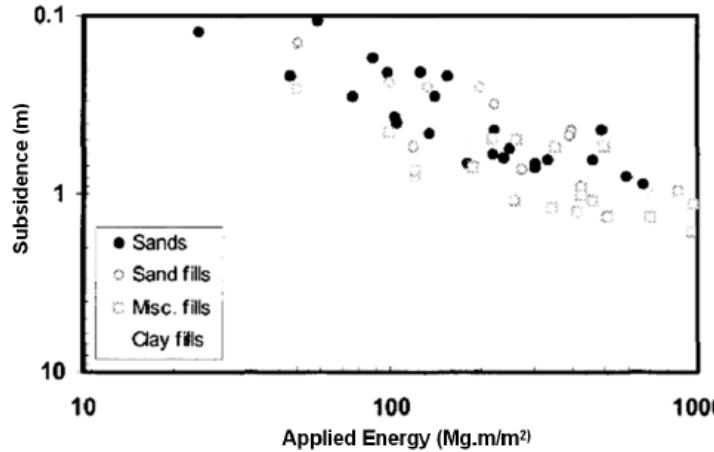
Figure 5. Ground subsidence vs. drop energy per unit area [7]. Table 5. Surface subsidence for different deposits (Solocombe, 1993).